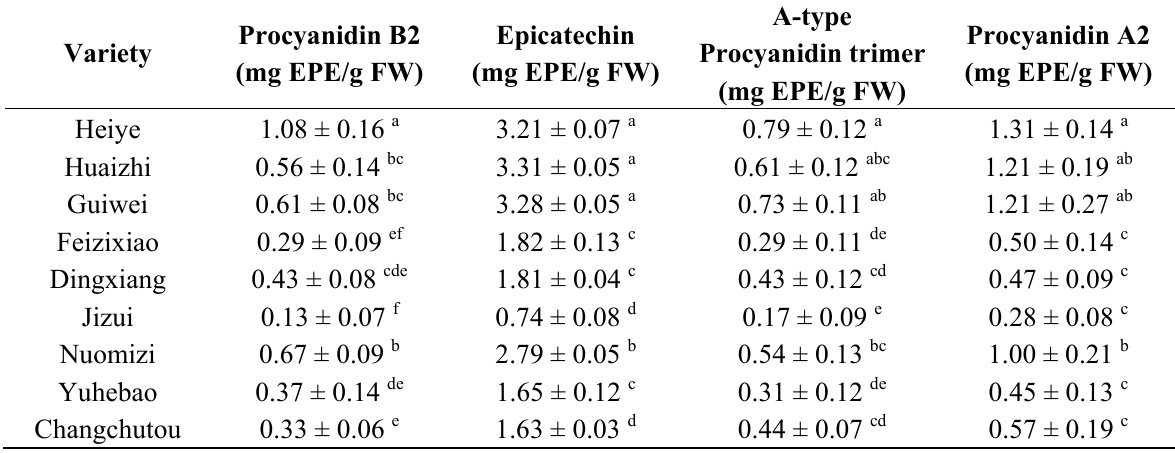
Table 3. Profiles of procyanidins in litchi pericarp of nine